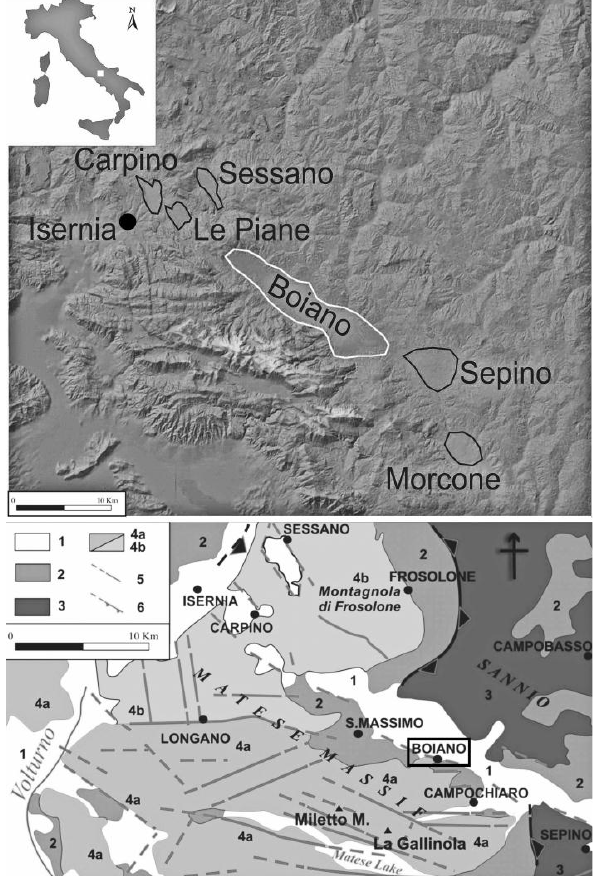
Fig. 2. Location, geological and morphotectonic contexts of the Boiano Basin (49 ◦ 29 0 N, 14 ◦ 28 0 E; ca. 500ma.s.l.) and of the main close sedimentary basins of the Molise region (from Aucelli et al., 2011). 1: fluviopalustrine deposits (Quaternary); 2: siliciclastic de- posits (Miocene); 3: clays, marls and limestones of Sannio (Up- per Cretaceous to Miocene); 4: limestones, dolomites, marls of car- bonate platform (a) and carbonate slope deposits (b) (Triassic to Miocene); 5: main thrusts; 6: main extensional faults.